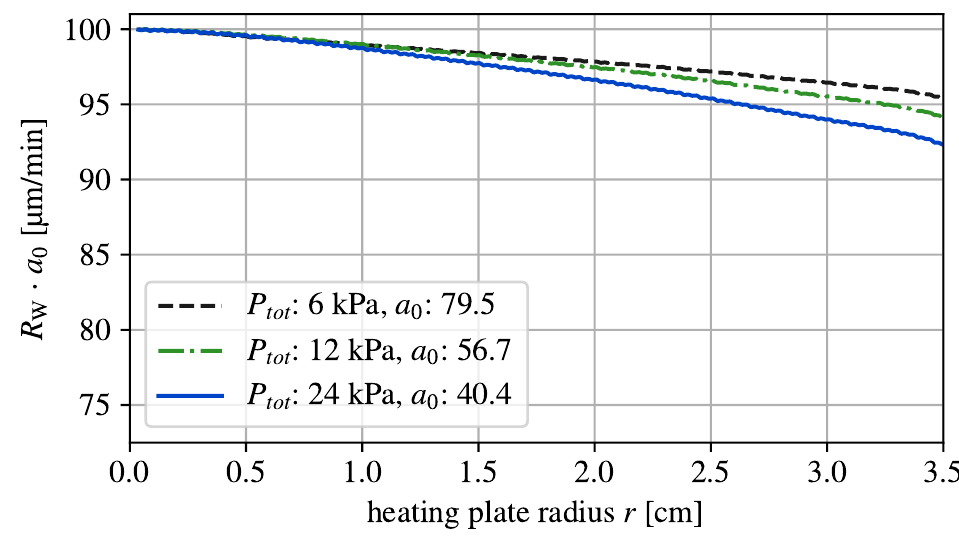
Figure 9. Variation of ˙ V inlet as in Figure 7).